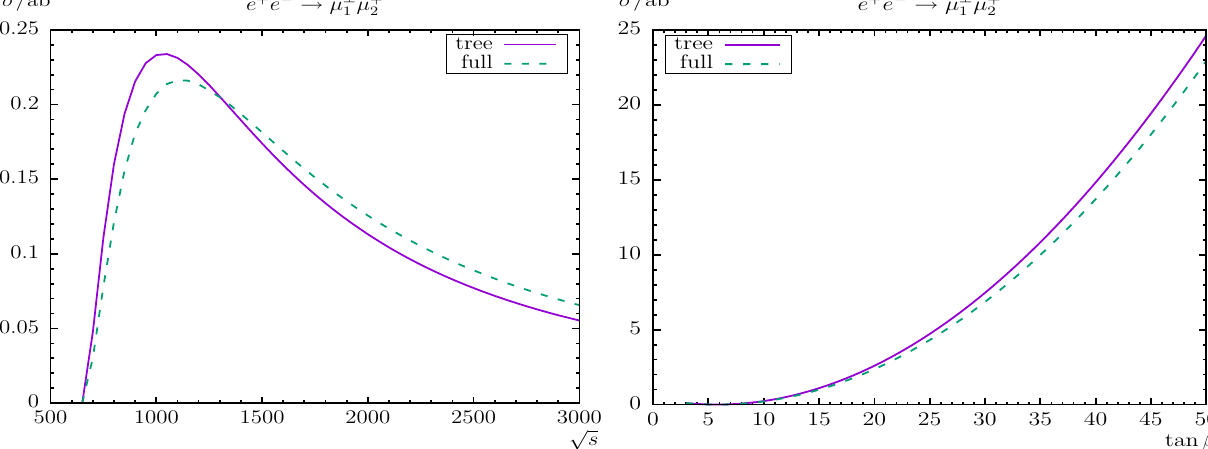
˜ μ ∓ ) . Tree-level and full one-loop corrected cross sections are shown with parameters chosen according to S ; see Table 1. Fig. 13 σ( e + e − → ˜ μ ± √ 1 2 s (left) and M ˜ The plots show the cross sections with (right) varied. All masses and energies are in GeV and the cross sections are in E